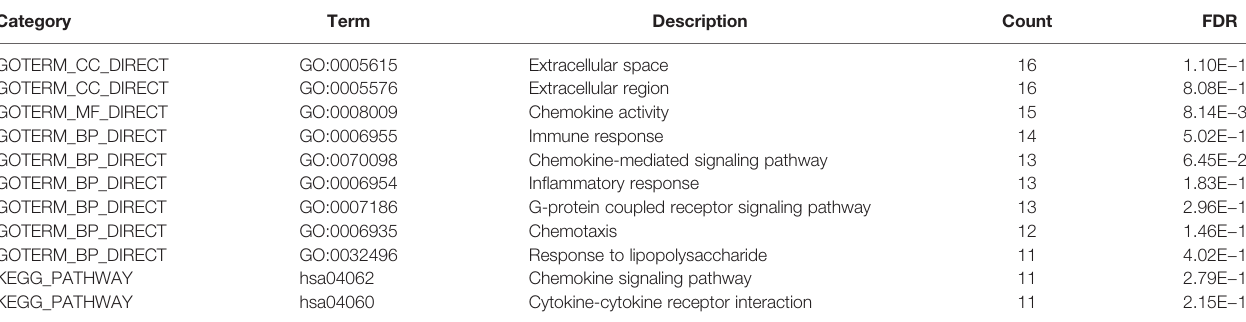
TABLE 2 | Signi fi cantly enriched GO terms and KEGG pathways of CXC chemokines in PAAD (DAVID 6.8).